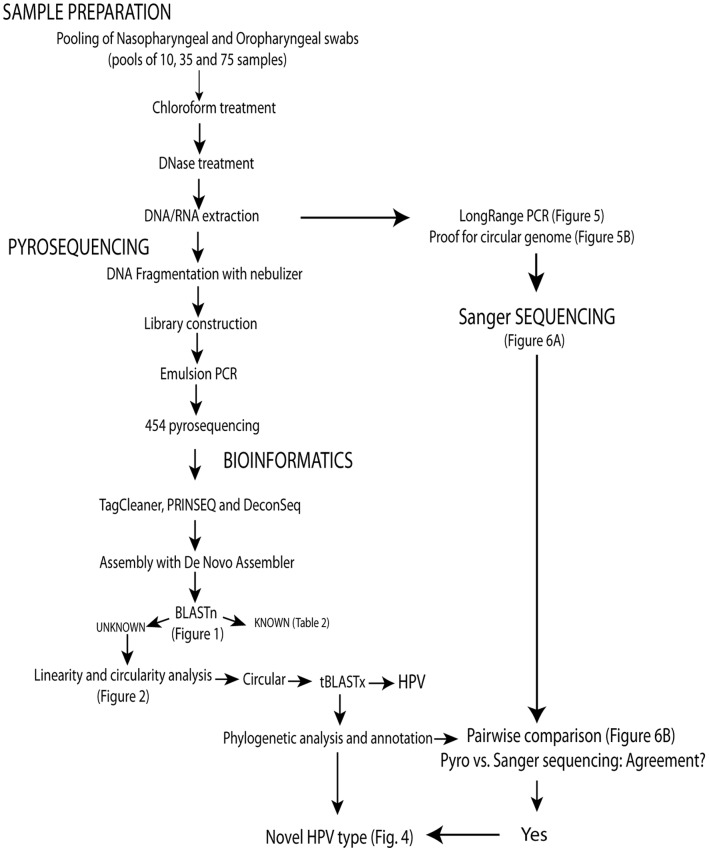
Outline of methods.